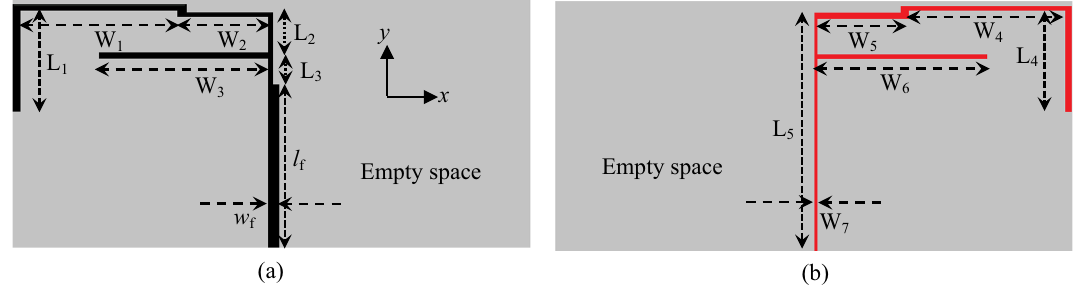
Figure 1. The geometry of the proposed antenna ( a ) Top view, and ( b ) bottom view.